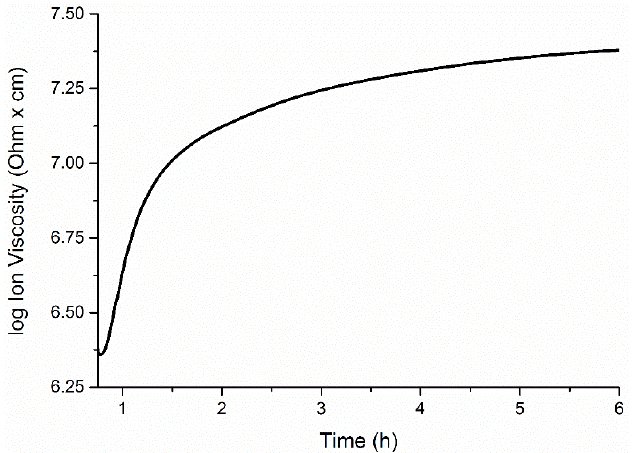
Figure 2. Dielectric analysis (DEA) of the cure of a tung oil-based thermosetting resin at 140 °C. The resin is composed of 70 wt % of tung oil, 15 wt % of divinylbenzene (DVB), 10 wt % of styrene (ST), 3 wt % of soybean oil, and 2 wt % of BF 3 ·OEt 2